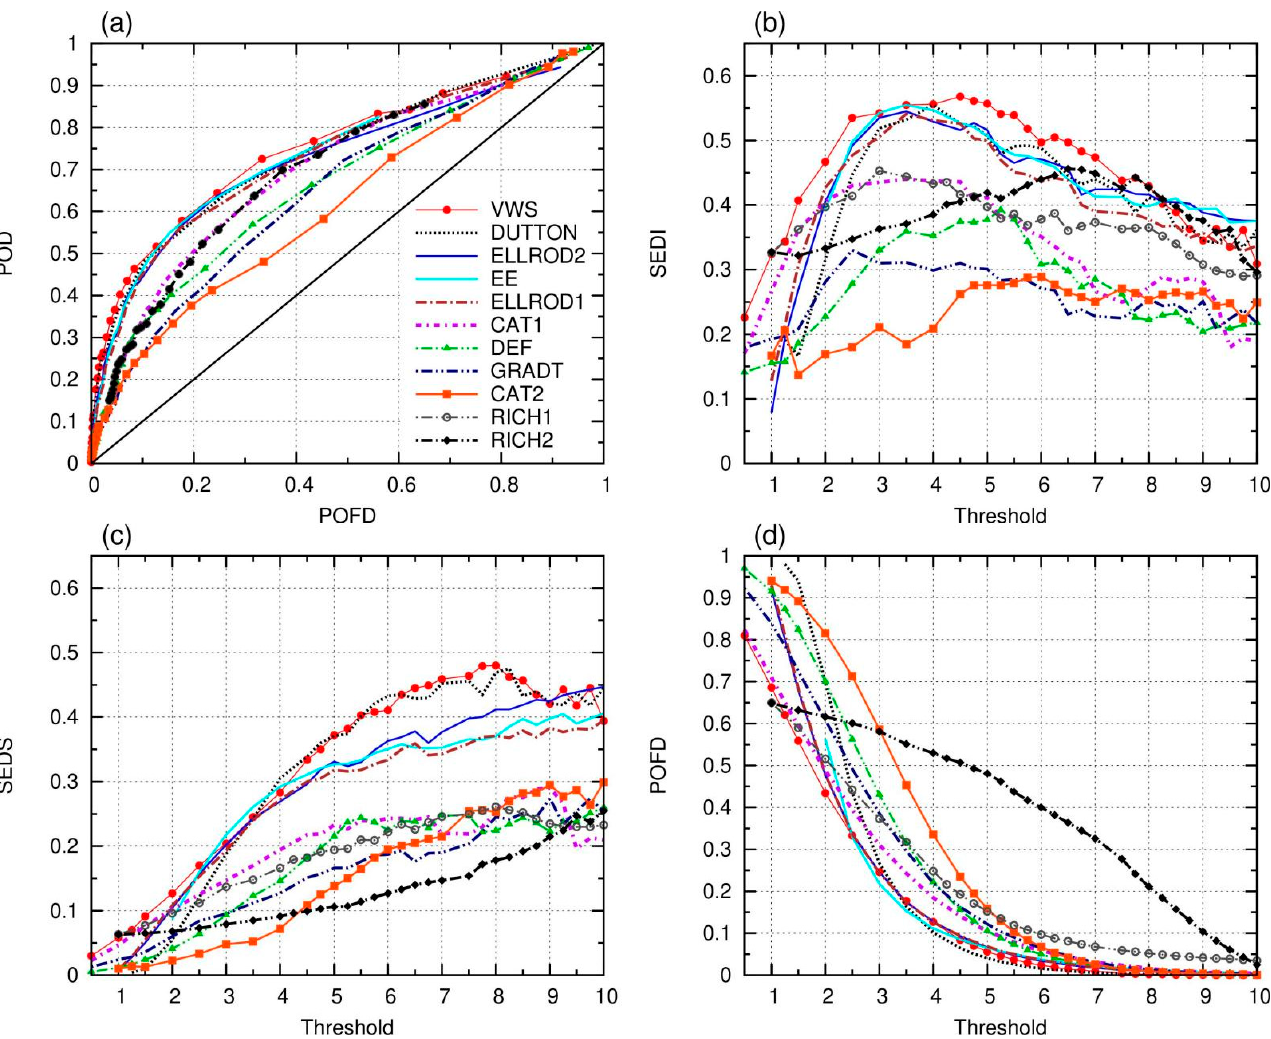
Figure 8. ( a ) ROC curves, ( b ) SEDI, ( c ) SEDS, and ( d ) POFD as a function of the threshold for several individual turbulence indicators (lines). The closer the ROC curve is to the upper left corner of the graph, the more skillful the index is. The ROC curves are defined by pairs of POD and POFD, computed for the various thresholds of the NWP-based turbulence indicators.